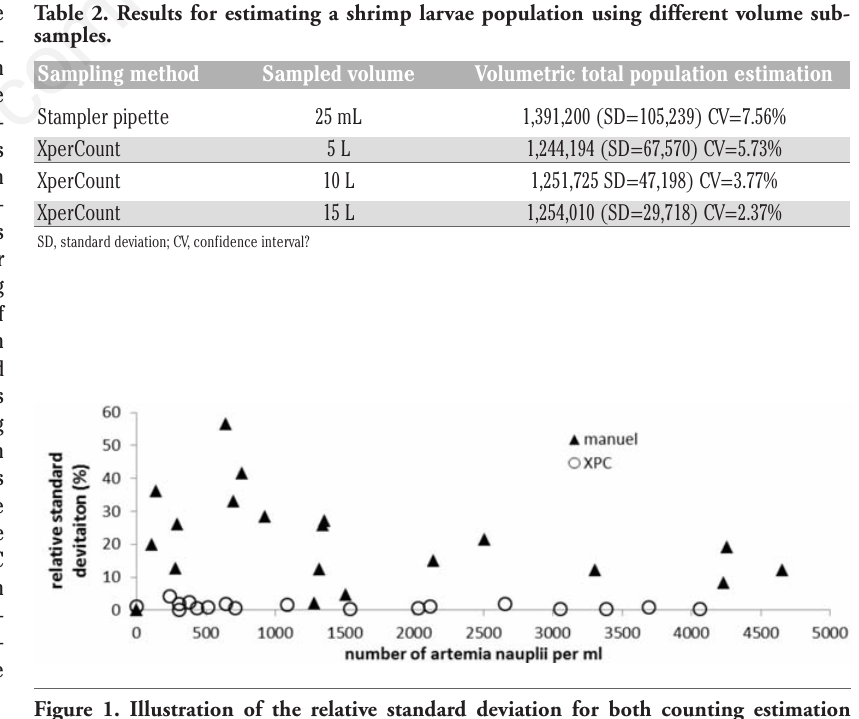
Figure 1. Illustration of the relative standard deviation for both counting estimation methods as a function of the concentration of Artemia nauplii per